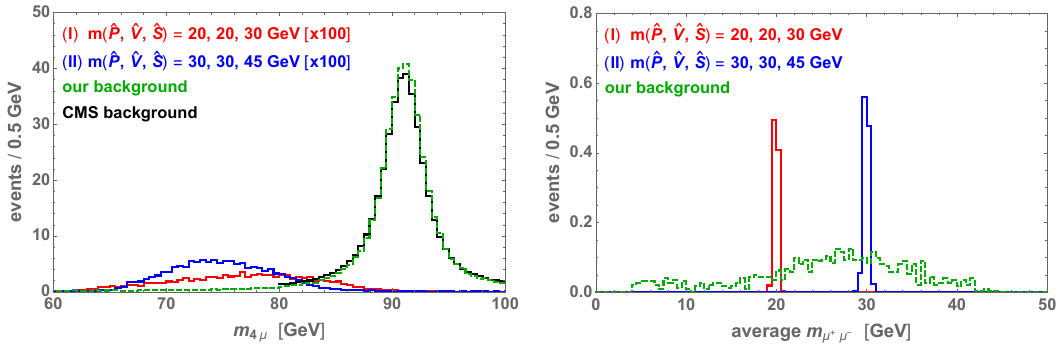
Figure 3 . Distributions for the Z ! ^ V ^ S ! 4 (cid:22) + X signal and SM background at the 13 TeV